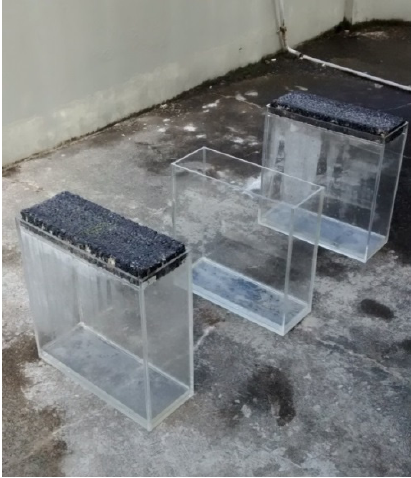
Figure 2. Boxes and slabs exposed to the rainfall events.